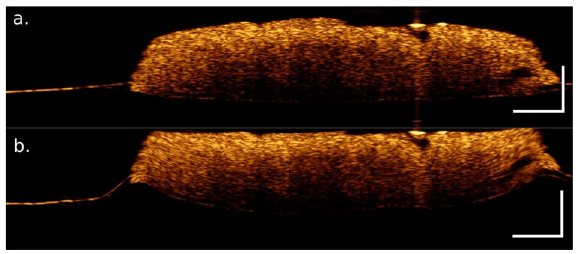
Figure 6. Surface adjusted OCT image (averaged over 5 B-scans) and extracted pure component spectra from the biopsies. Most of the biopsy samples have an uneven surface, resulting in challenges during the analysis, ( a ) To remove the curvature observed in the OCT images an inhouse developed algorithm, based on gradient surface position detection was used to determine the surface location and adjust, i.e. flattening, the surface, ( b